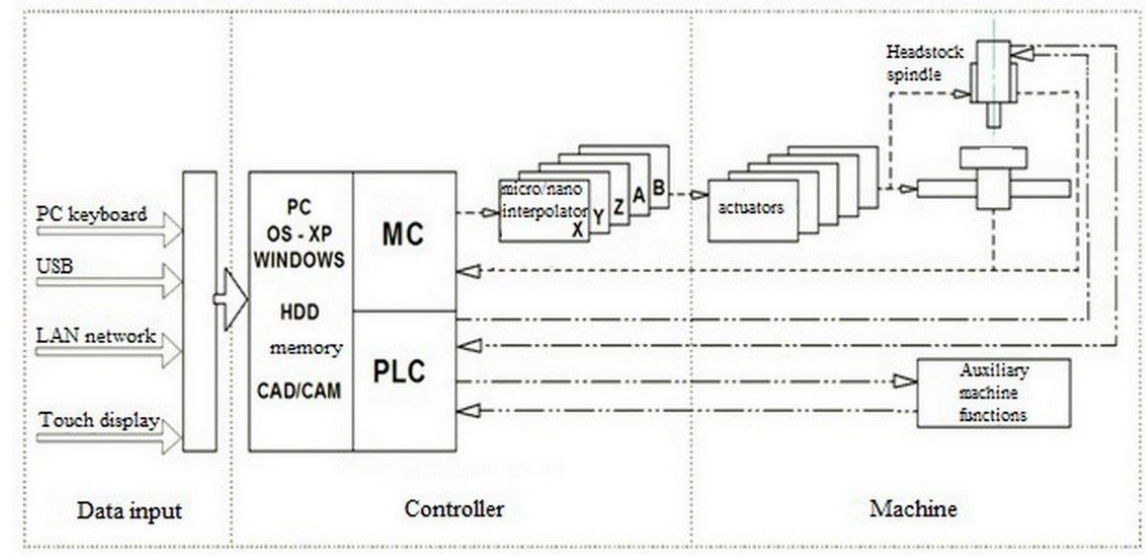
Figure 1: Block diagram of the CNC machine tool [1].